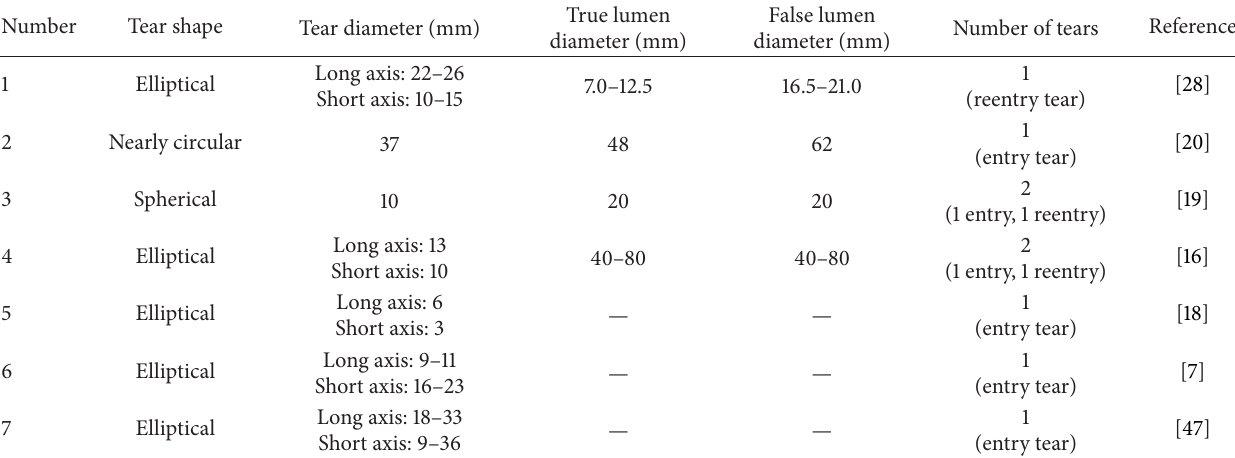
Table 2: Tear configurations used in numerical simulations for aortic